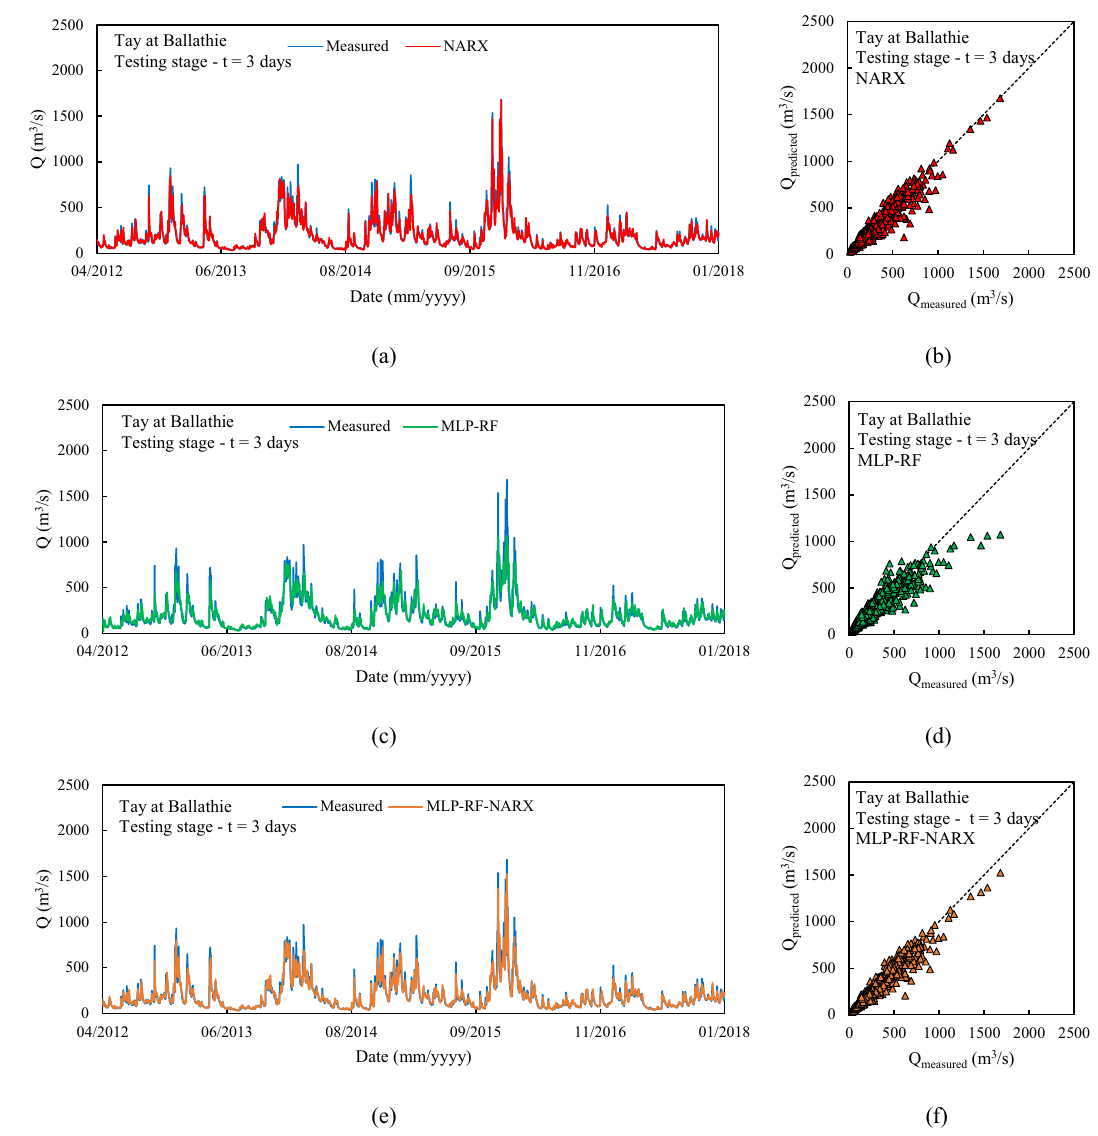
Figure 7. 3-days ahead predictions for Tay at Ballathie: NARX ( a , b ); MLP-RF ( c , d ); MLP-RF-NARX ( e , f